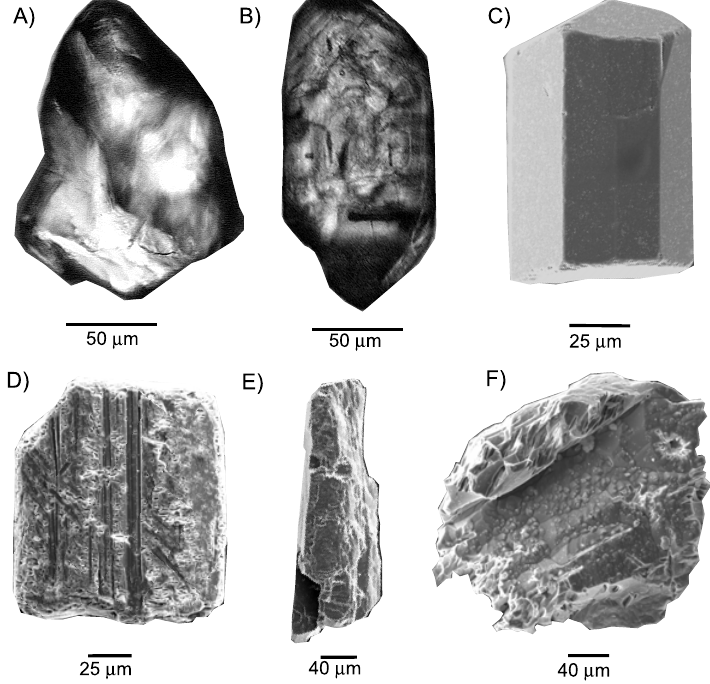
Fig. 5 – Main characteristics of the heavy minerals from the lower kaolin unit, illustrat- ing: A) anhedric angular zircon; B) euhedric zircon displaying internally growth lines; C) euhedric tourmaline; D) altered tourmaline; E) altered kyanite; and F) altered staurolite.